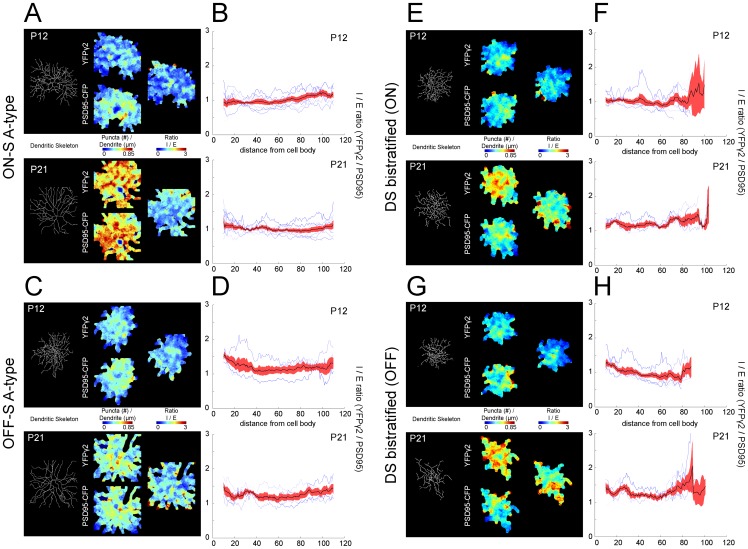
Spatial density heat maps of GABAergic and glutamatergic postsynaptic sites on RGC dendritic arbors.(A) (Left) Dendritic skeletons of ON-S A-type RGCs at P12 and P21. (Middle) Synaptic density maps were created by convolving a 10 µm disk centered on each pixel of the MIP of the dendritic skeleton puncta linear density [puncta (#)/dendrite (µm)] for YFPγ2 (upper) and PSD95CFP (lower). (Right) Ratio of YFPγ2/ PSD95CFP puncta across ages. (B) YFPγ2/ PSD95CFP ratio plotted against eccentricity (distance from cell body). Each blue line represents a cell, black line is mean and red shading SEM. Analysis of OFF-S A-type RGC is shown in (C, D) and of ON and OFF arbors of bistratified DS RGCs in (E–H).